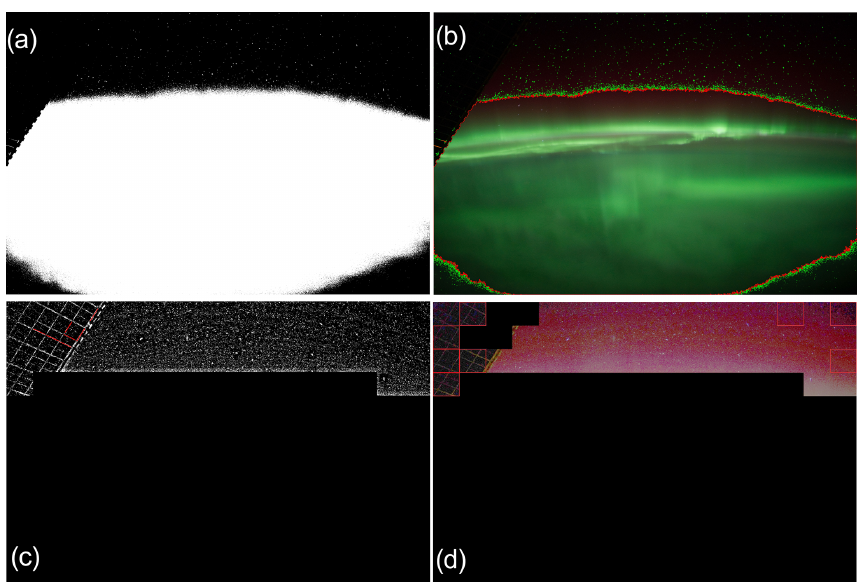
Figure 3. Stages of the automatic image masking process. (a) The image is reduced to two colours to identify dark regions likely to be star field. (b) The resulting contour is applied to the original image. (c, d) Image blocks not detected as star field are masked and edge detection is applied to detect and mask linear features likely to be space station